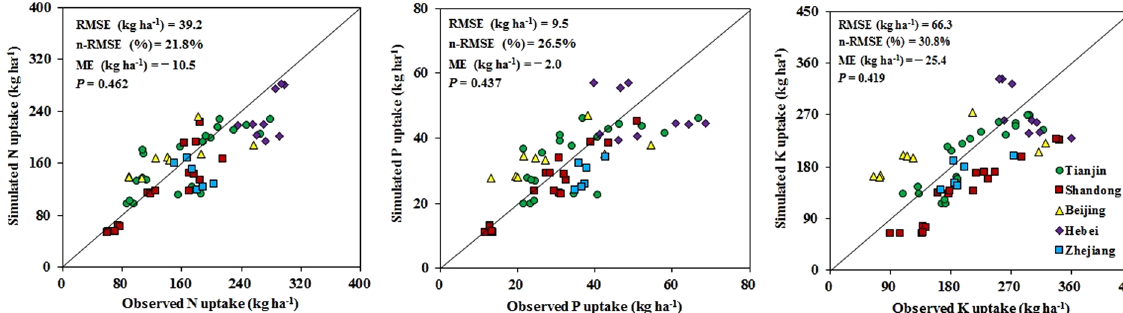
Figure 4. Comparisons of the simulated and observed data of N, P, and K uptake in whole radish plant dry matter in 2016–2018. The observed data were obtained from field experimental plots where the Nutrient Expert (NE) decision support system was applied. The simulated nutrient uptake data were estimated using the QUEFTS